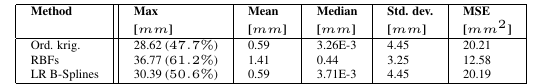
Table 4: Statistics for the maximum number of extracted persis- tent maxima. Method